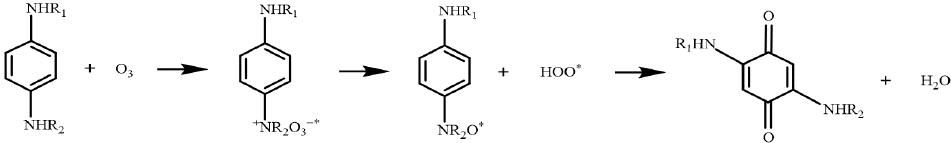
Figure 2. The mechanism of the PPD antioxidant ozonation (* represents radical) [34,35] .